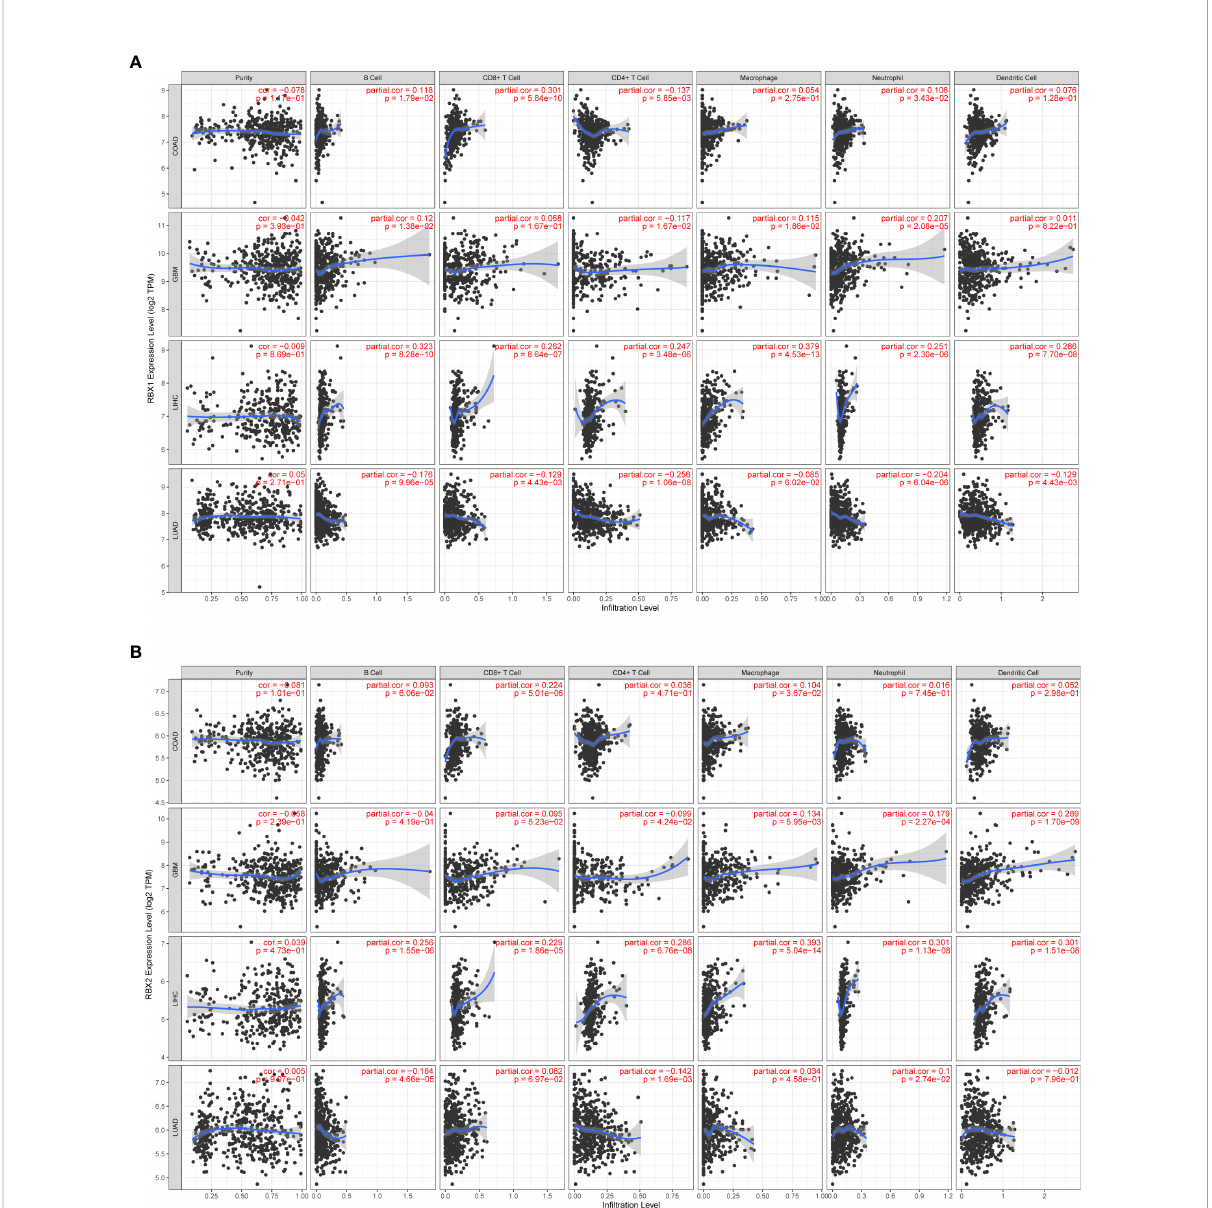
FIGURE 7 Correlation of RBX1/2 expression with immune in fi ltration level in COAD, GBM, LIHC and LUAD. (A) RBX1 expression is related with the level of immune in fi ltration in the above four cancers. (B) RBX2 expression is related with the level of immune in fi ltration in the above four cancers. P value less than 0.05 is considered as